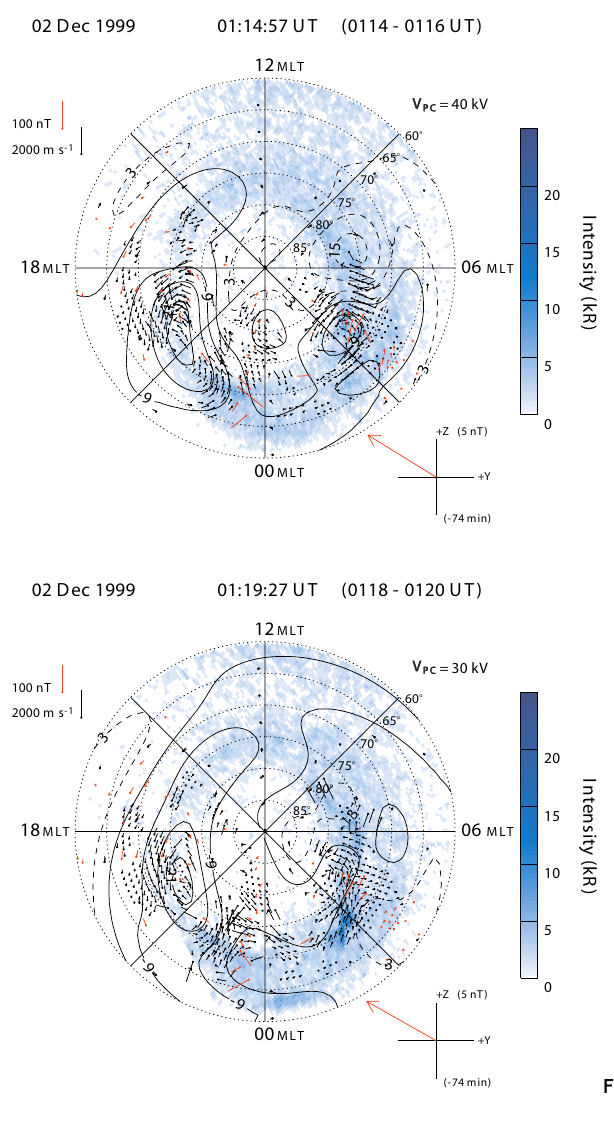
Fig. 7. Maps of the UV auroral lu- minosity projected onto a geomagnetic grid are shown spanning the same in- terval as in Fig. 6. SuperDARN Map- Potential streamlines and flow vectors are superposed. Magnetic data, shown in red, are horizontal magnetic pertur- bation vectors which have been rotated anti-clockwise through 90 ◦ to point in the direction of the E × B drift, as- suming they are due wholly to over- head Hall currents. Also indicated on the maps is the derived total transpolar voltage and the direction and magnitude (in the Y − Z plane) of the IMF, as in Fig. 6. The time indicated on each plot corresponds to the center time of the 32.5s integration interval of the UV im- age. The superposed SuperDARN and 2-min averaged magnetic vectors corre- spond to the interval shown in brackets, which encompasses the center time of Fig. 7e the UV